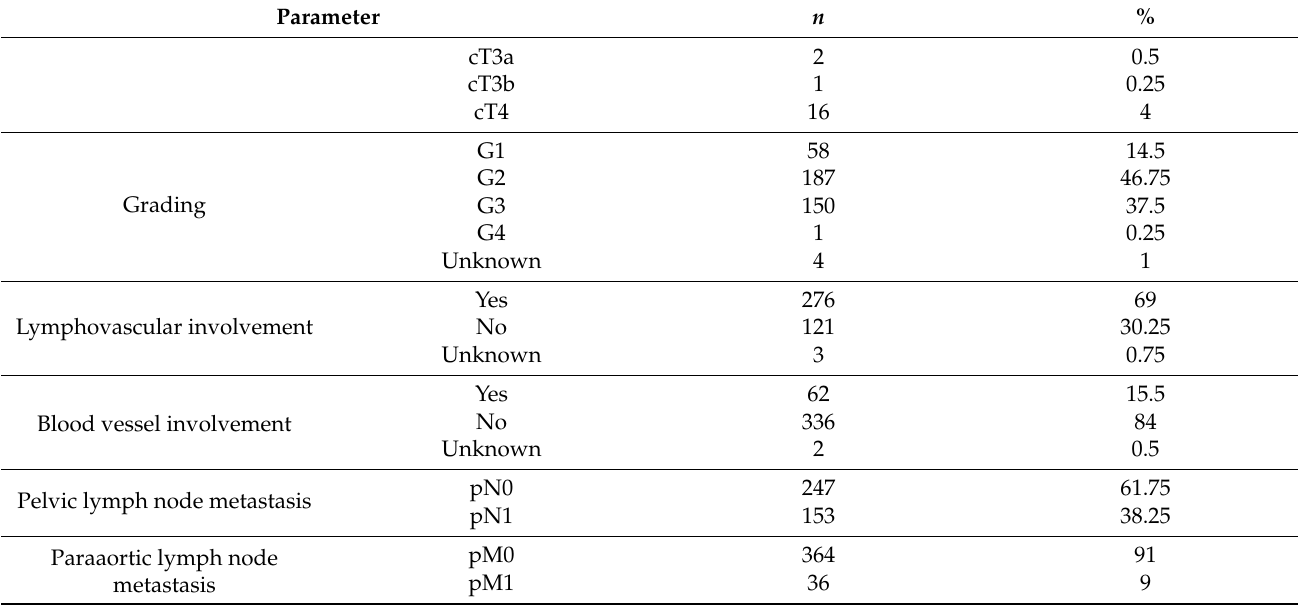
BMI: body mass index. FIGO: Fédération Internationale de Gynécologie et d’Obstétrique. IQR: Interquartile range. MRI: magnetic resonance imaging.